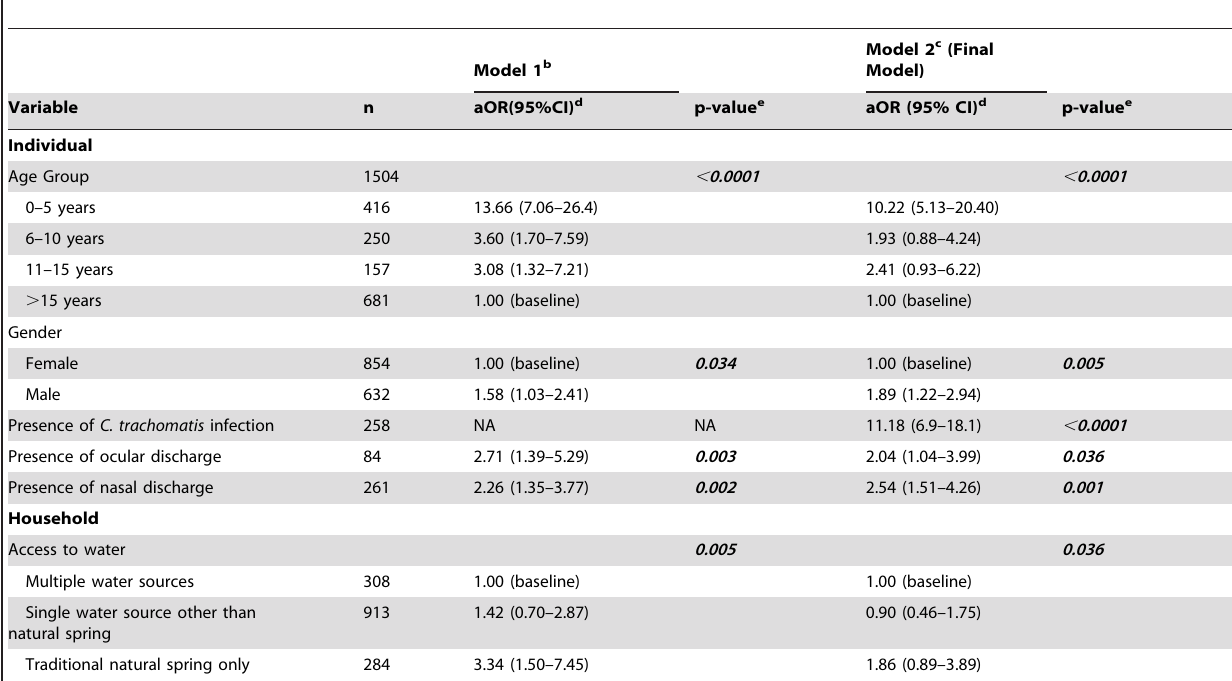
Table 4. Multilevel multivariable random effects logistic regression analysis of factors independently associated with active trachoma a